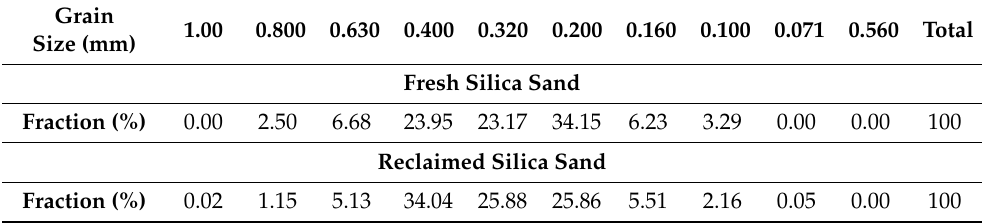
Table 2. Grain size distribution of fresh and reclaimed silica